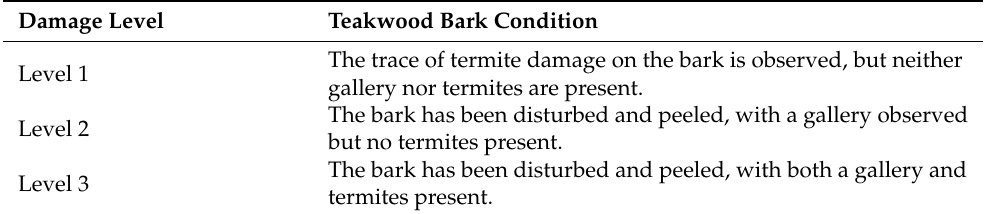
Table 1. Damage level of teakwood trunks caused by termites based on the bark condition.